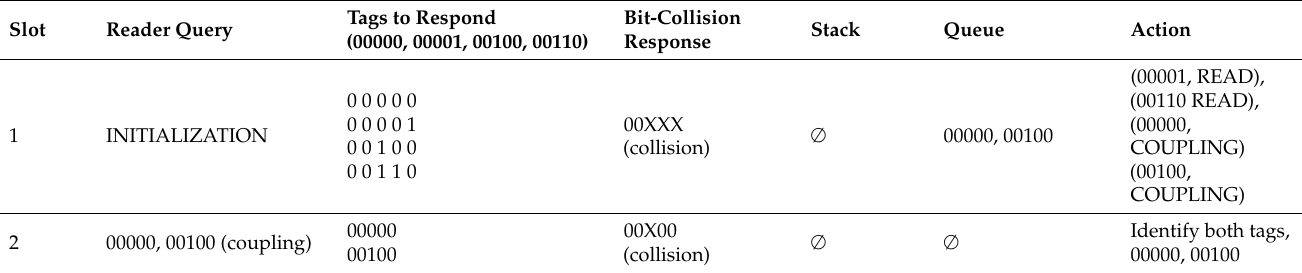
Table 3. Another example of BKQT